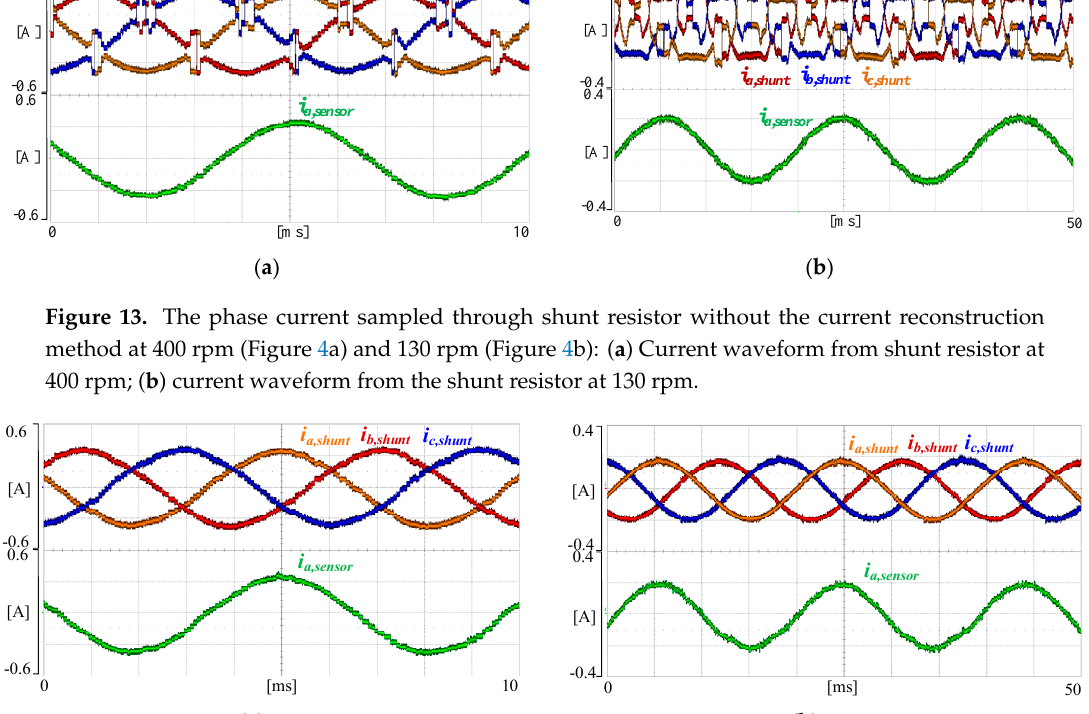
Figure 14. The phase current sampled through shunt resistor with the proposed current estimation method at 400 rpm (Figure 4a) and 130 rpm (Figure 4b): ( a ) Current waveform from shunt resistor at 400 rpm; ( b ) current waveform from the shunt resistor at 130